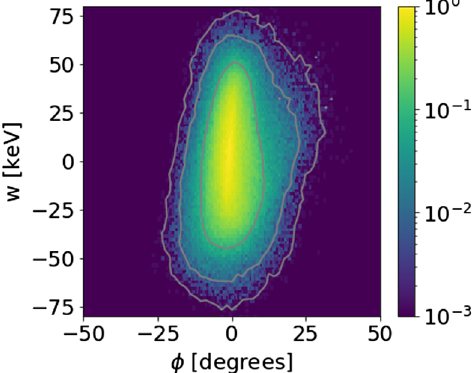
FIG. 4. Expected longitudinal phase space generated via PARMTEQ and P y ORBIT propagation of the realistic LEBT distribution. Emittance is plotted at the location of the first slit in the